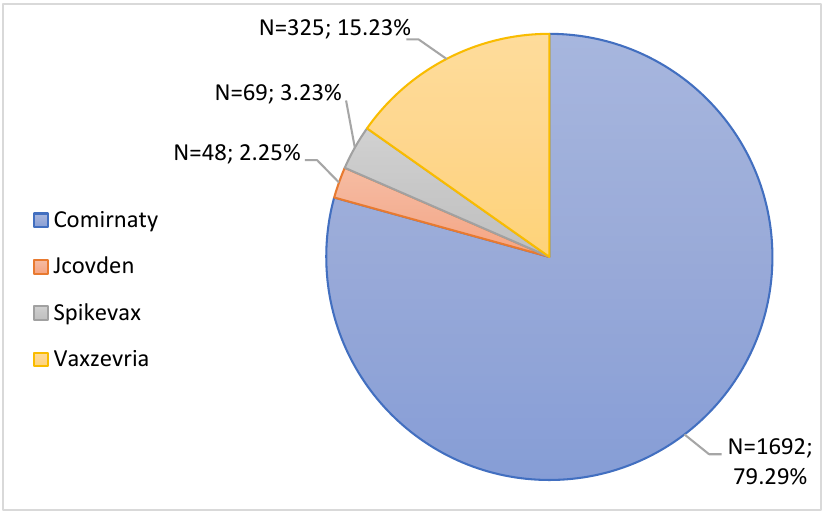
Figure 5. Characterization of notifications according to the brand name of the vaccine.